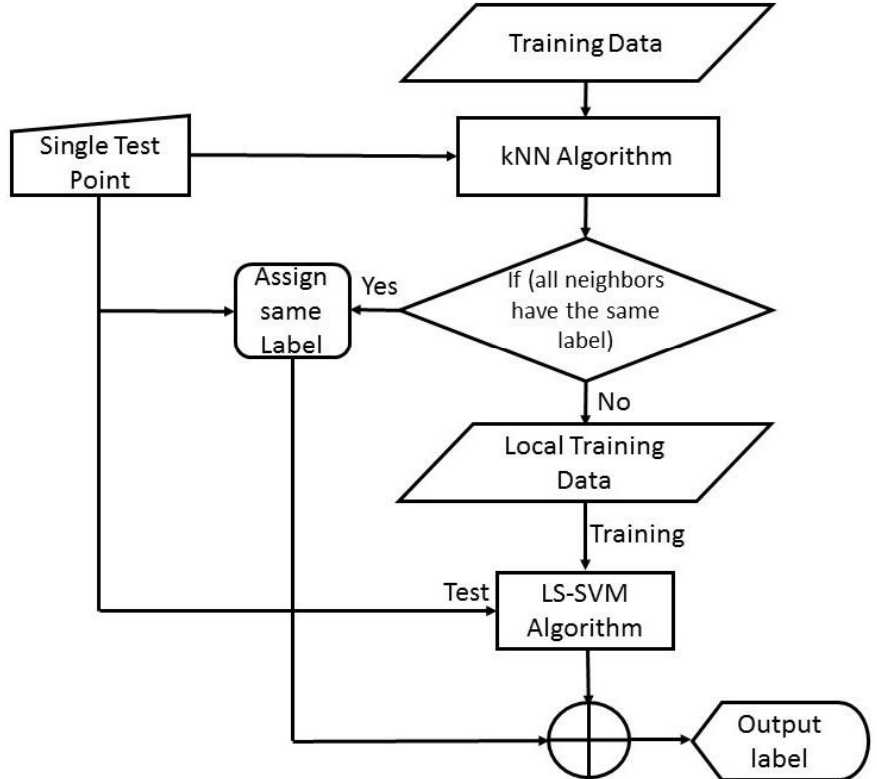
Figure 1. A flow chart illustrating the algorithm of K-Nearest Neighbours Least Squares Support Vector Machines (KNN-LS-SVM)